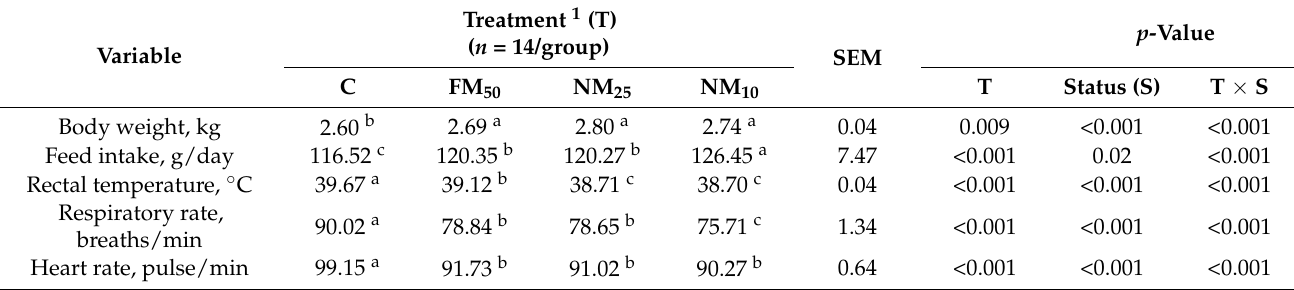
Table 5. Effect of the nanoencapsulated Moringa leaf ethanolic extract (MLEE) on the physiological parameters of a female rabbit during the experimental period (mean ±